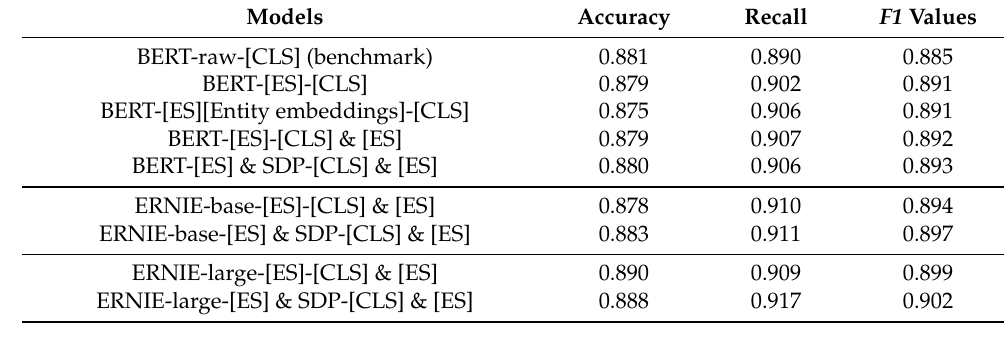
Table 7. The results of the ablation experiment.